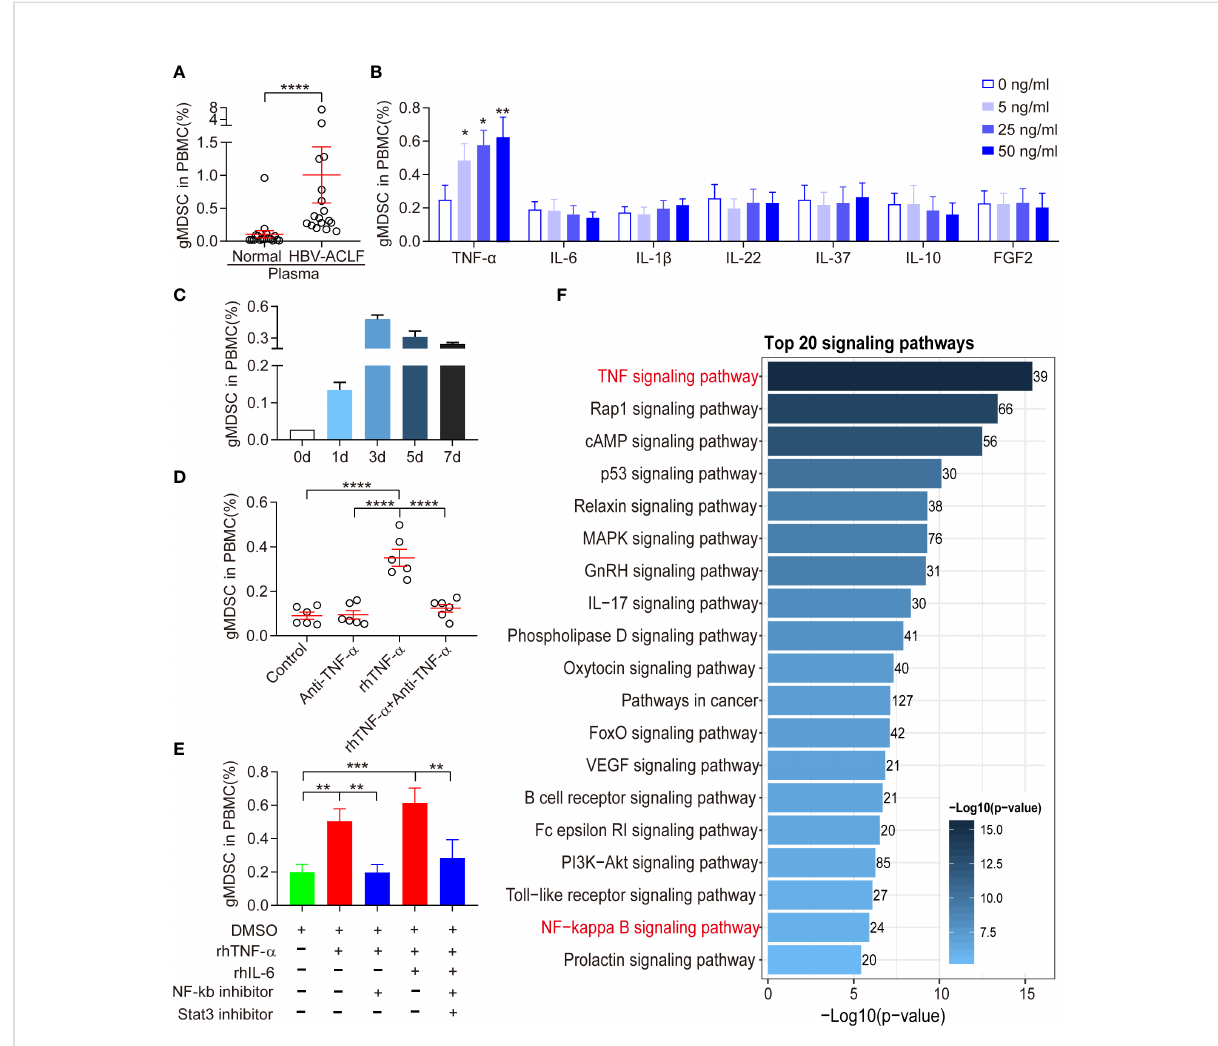
FIGURE 3 Expansion of gMDSC was dependent on TNF- a . (A) Cumulative dot plots of gMDSC proportion when PBMCs were exposed to plasma from HC or HBV-ACLF patients. (B) Histogram of gMDSC proportion when PBMCs were exposed to different concentrations of recombinant human (rh) cytokines (TNF- a , IL-6, IL-1 b , IL-22, IL-37, IL-10, and FGF2). (C) Histogram of gMDSC proportion after rhTNF- a stimulated HC PBMCs for 1, 3, 5, and 7 days (n = 3). (D, E) Cumulative dot plots of gMDSC proportion when HC PBMCs were co-cultured with rhTNF- a , rhIL-6, anti-TNF- a , NF- kb inhibitor, and Stat3 inhibitor for 3 days. (F) TNF signaling was the most active pathway in gMDSC puri fi ed from HBV-ACLF. Error bars, mean ± SEM; Wilcoxon test (A – E) ; *P <.05, **P <.01, ***P <.001, and ****P